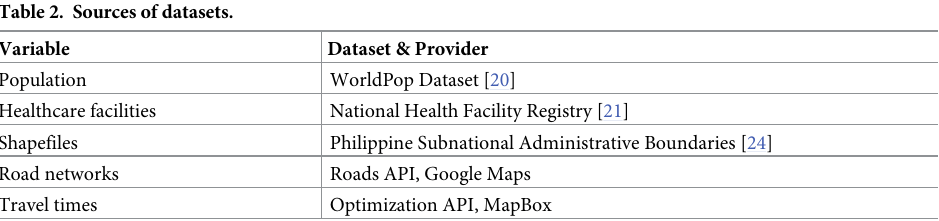
Table 2. Sources of